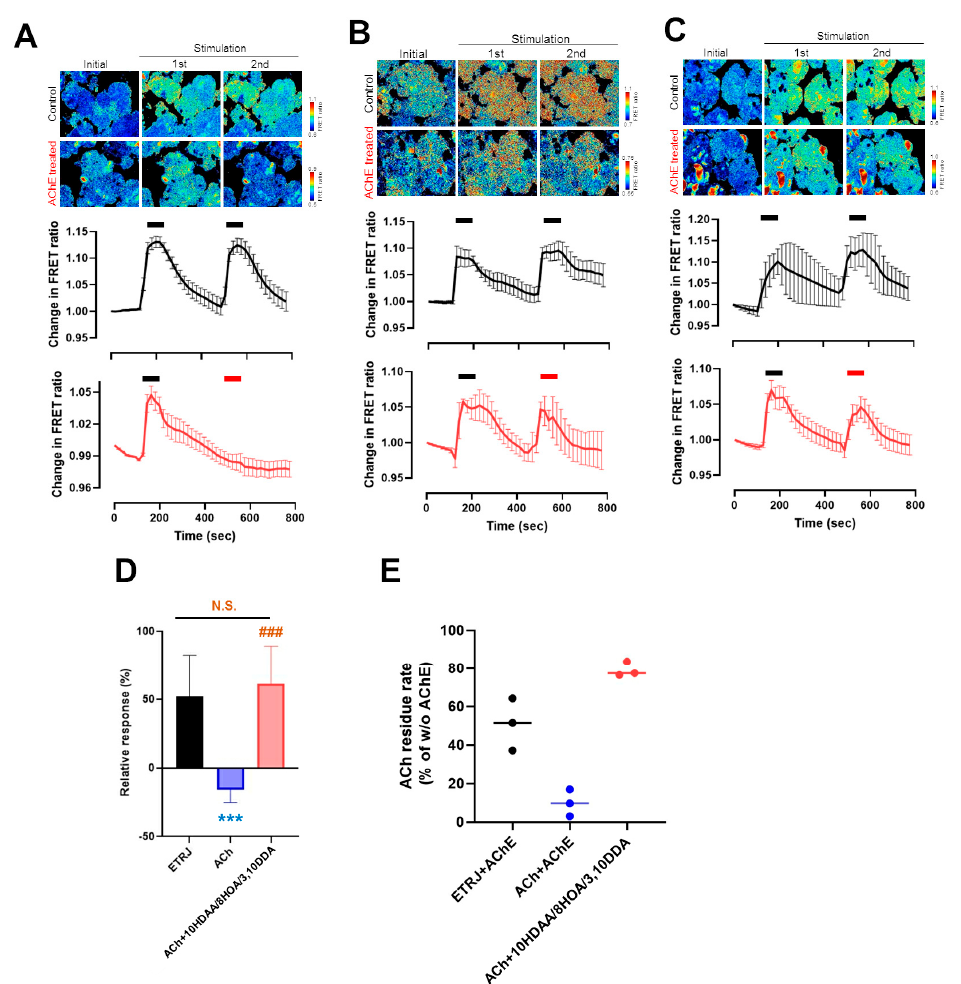
Figure 4. 10HDAA/8HOA/3,10DDA suppressed the decrease of Ach-modulated LG [Ca 2+ ]i by ACh esterase. [Ca 2+ ]i increase in LG acinar cells exposed to ( A ) ACh, ( B ) ETRJ, and ( C ) ACh + 10HDAA/8HOA/3,10DDA treated with or without ACh esterase (AChE). The upper panels show pseudo-colored images of [Ca 2+ ]i. The lower trace shows the [Ca 2+ ]i response to each stimulus. The black and red bar over the trace indicates when each stimulus reacted without and with AChE, respectively. ( D ) Summarized data on amplitudes of [Ca 2+ ]i responses. Relative responses were calculated as a percentage of stimulus reacted with the AChE induced [Ca 2+ ]i response relative to the stimulation induced without AChE. ( E ) Analytical quantification of ACh. All data represent the mean ± SEM, n = 4–10 LGs ( A – D ) and n = 3 ( E ). *** p < 0.001 versus ETRJ, ### p < 0.001 versus ACh. N.S. indicates no significant difference between ETRJ and ACh with 10HDAA/8HOA/3,10DDA ( D ).